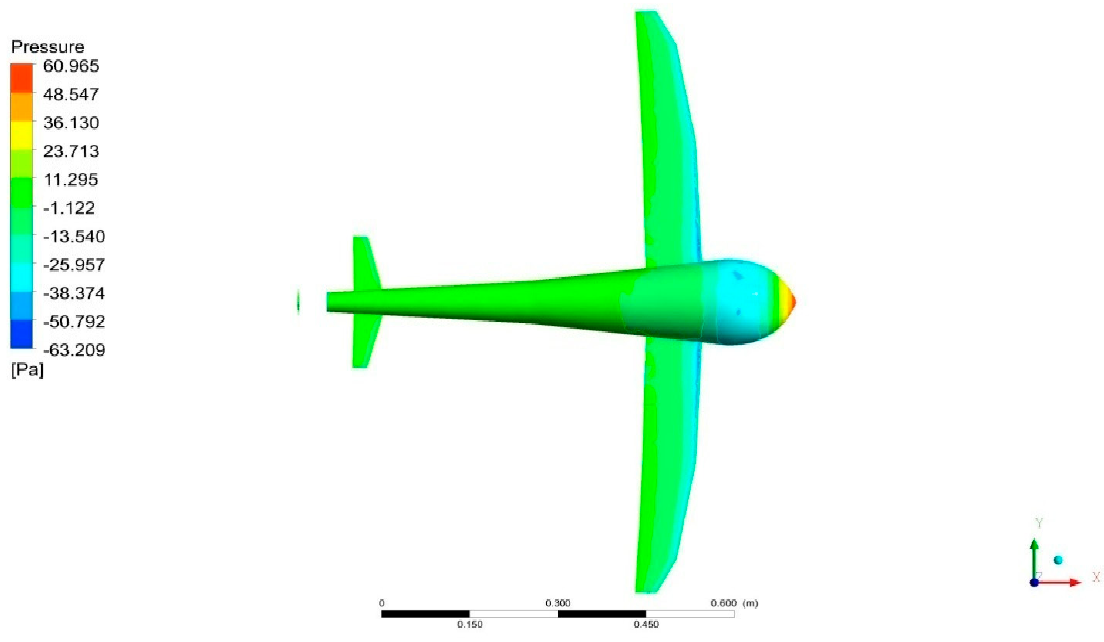
Figure 15. Aerodynamic Pressure variations on UAV when flying above the ocean.